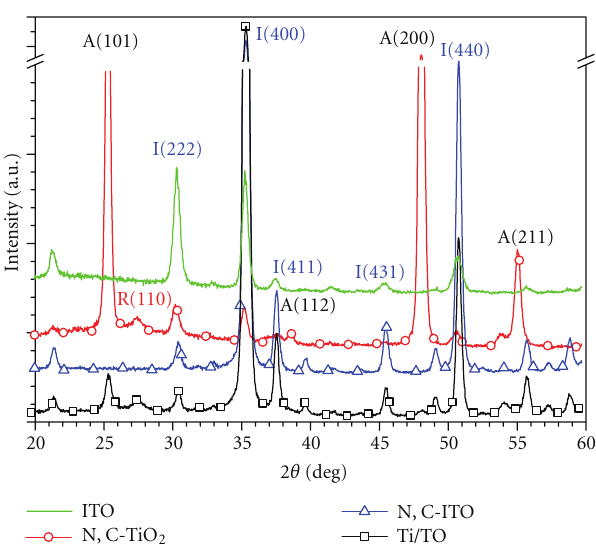
Figure 1: XRD patterns of the composite Ti/TO electrode along with N,C-TiO 2 , N,C-ITO, and ITO film electrodes, where A, R, and I stand for anatase, rutile, and ITO phase,